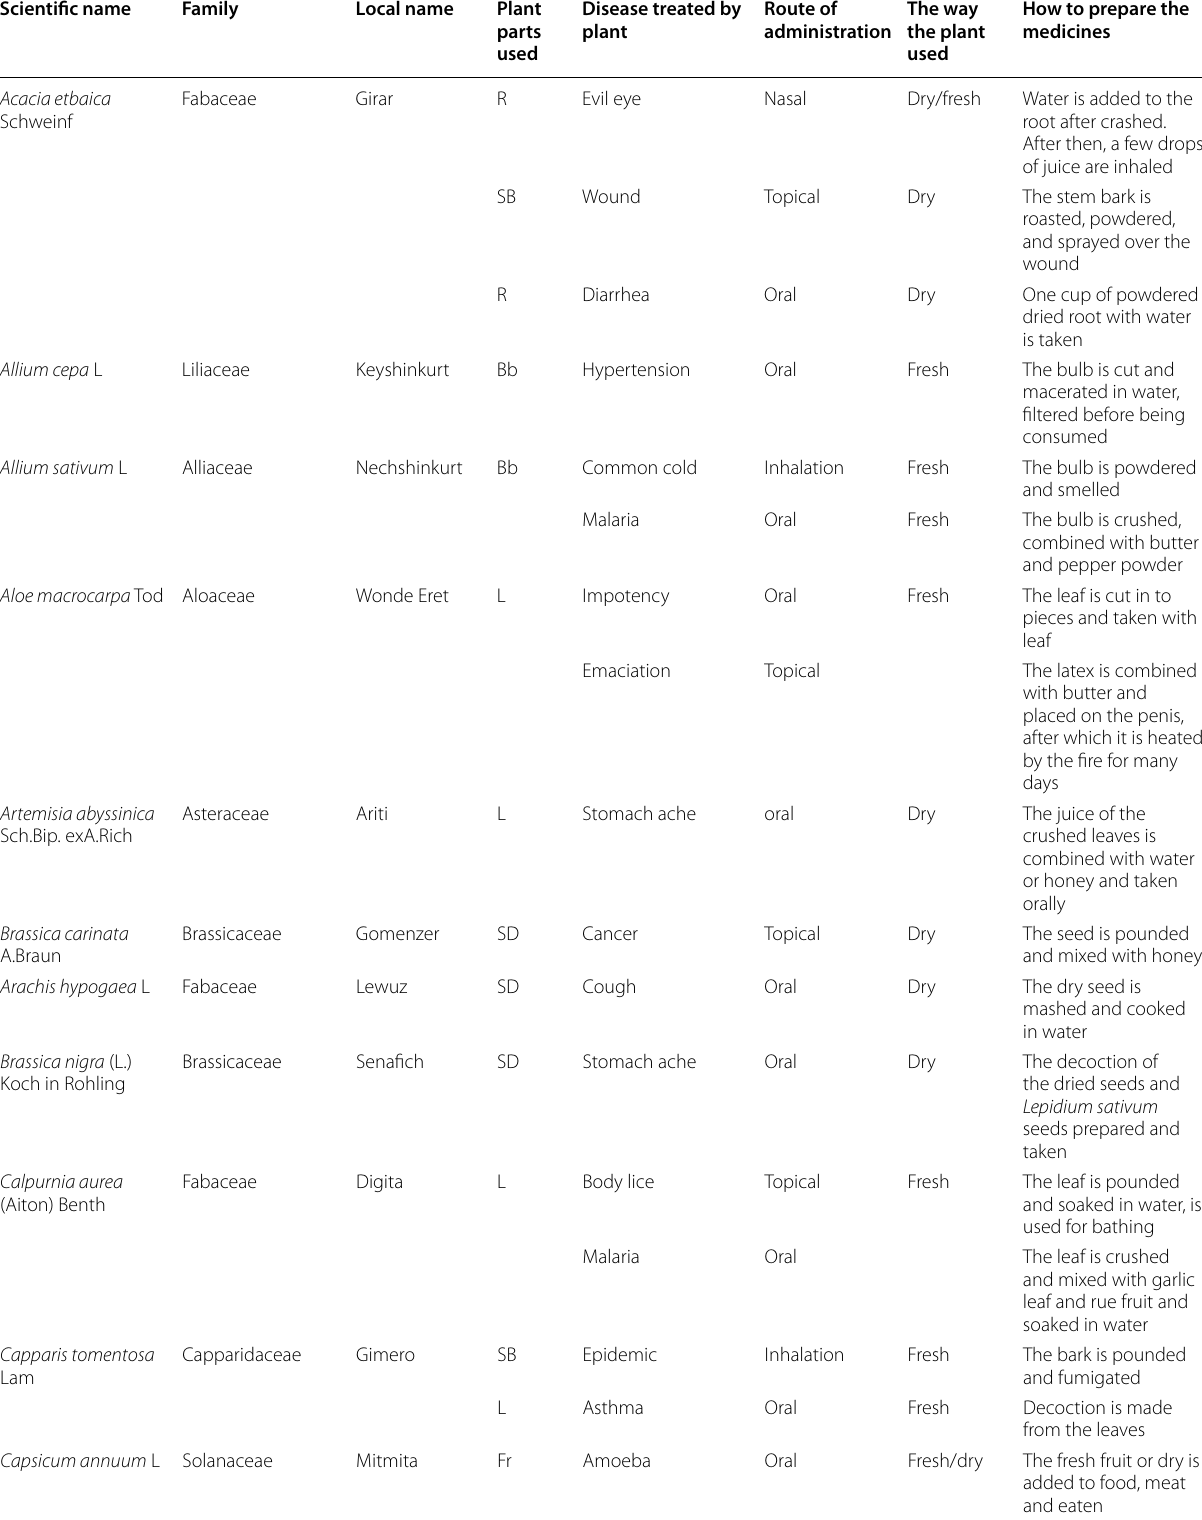
Table 1 List of medicinal plants used to treat human ailment by Artuma Fursi district Scientific